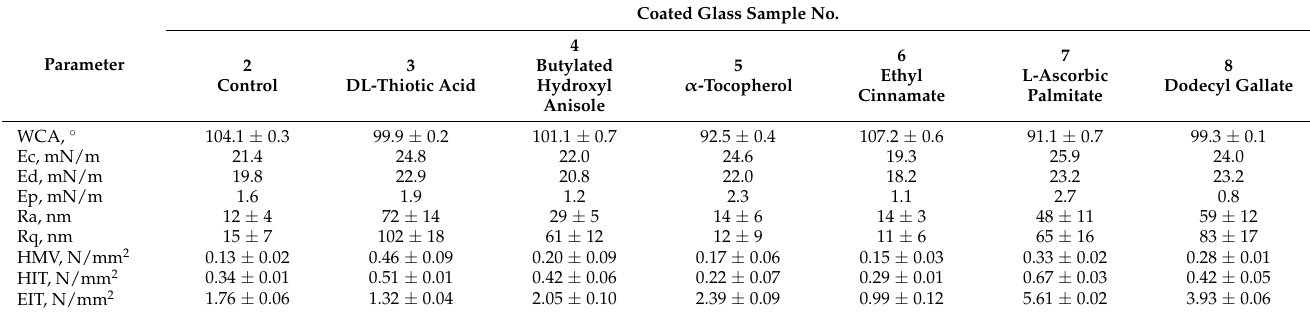
Table 1. Surface physical-chemical characteristics: water contact angle (WCA), surface energy (E c ), disperse (E d ) and polar (E p ) components; surface roughness (Ra, Rq) and physical-mechanical parameters: dynamic Vicker’s hardness (HMV), indentation hardness (HIT), and indentation elastic modulus (EIT) of the studied coatings: (2)—Control without antioxidant; or containing 2 wt.%: (3)—DL-Tioctic acid; (4)—Butylated hydroxyanisol; (5)— α -Tocopherol; (6)—ethyl cinnamate; (7)—L- ascorbil palmitate; (8)—dodecyl